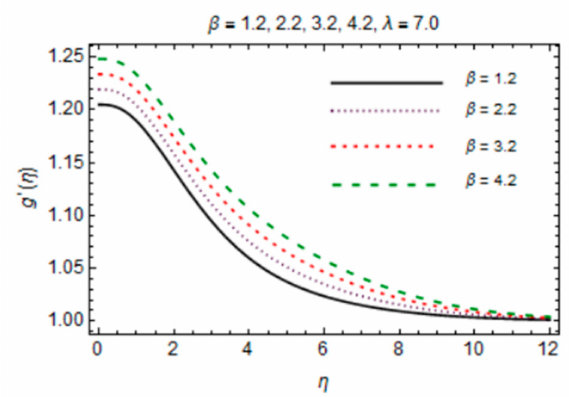
Figure 9. β verses induced magnetic field